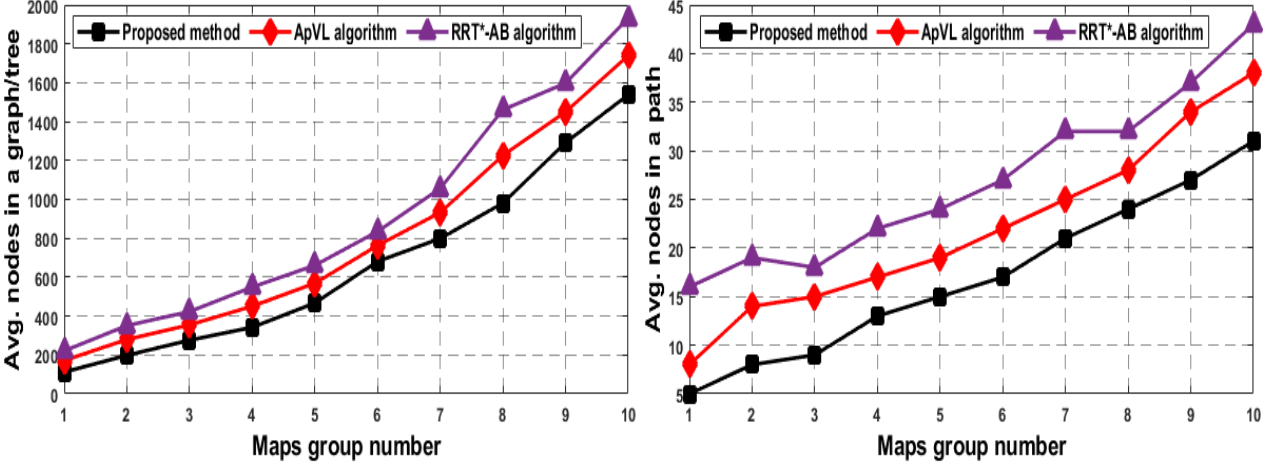
Figure 11. ( Left ) Graph/tree nodes: proposed method versus the ApVL algorithm and the RRT*-AB algorithm; ( Right ) path nodes: proposed method versus the ApVL algorithm and the RRT*-AB